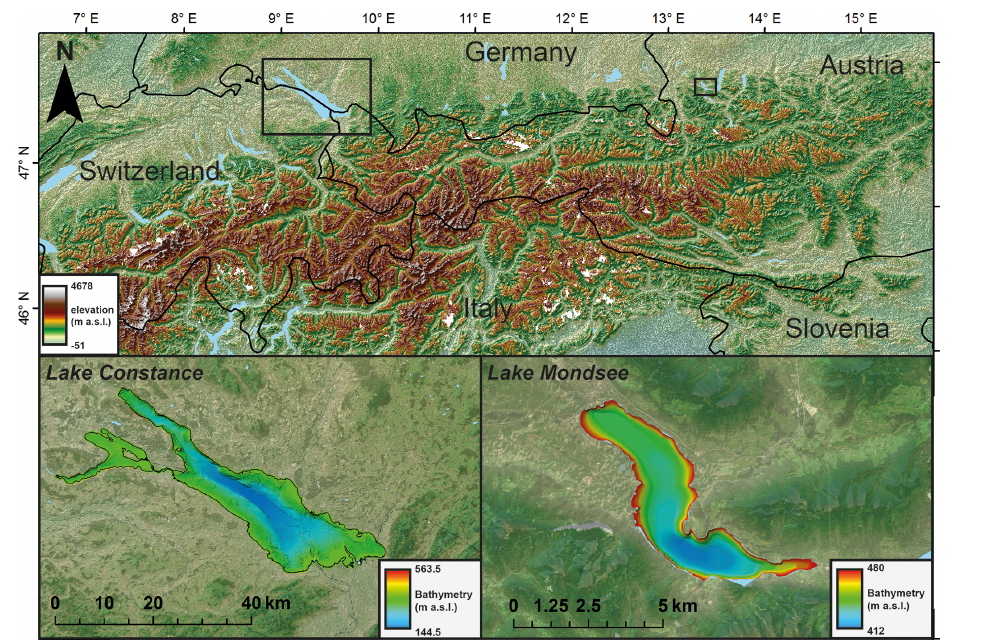
Figure 1. Digital elevation model of the Alpine chain in central Europe based on Shuttle Radar Topography Mission (SRTM) 1arcsec imagery (30m; USGS Explorer) with borders as solid black lines and all major lakes in blue. Insets show lakes Constance (Wessels et al., 2015; bathymetry and offshore lidar) and Mondsee, with bathymetric information (data from Mondsee bathymetry courtesy of Immo Trinks, Ludwig Boltzmann Institute for Archaeological Prospection and Virtual Archaeology, Vienna) superimposed using Universal Transverse Mercator (UTM) coordinates. The inset maps combine elevation data with topographic maps (orthographic aerial and satellite imagery from Bing Maps, © Microsoft